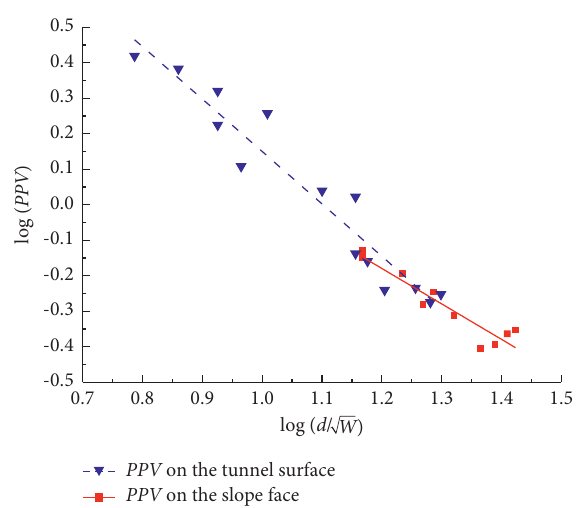
Figure 6: Vector PPV versus scaled distance on the log-log plot based on the field monitoring data.